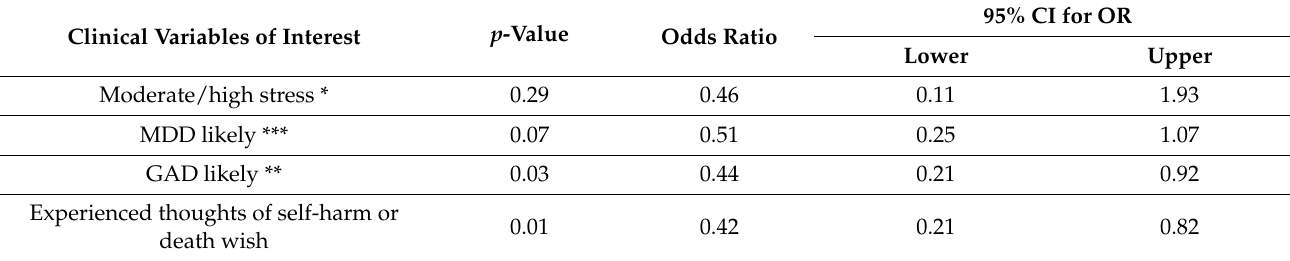
Table 7. Odds for subscribers in the IG to have various clinical characteristics compared to the CG when controlling for demographic